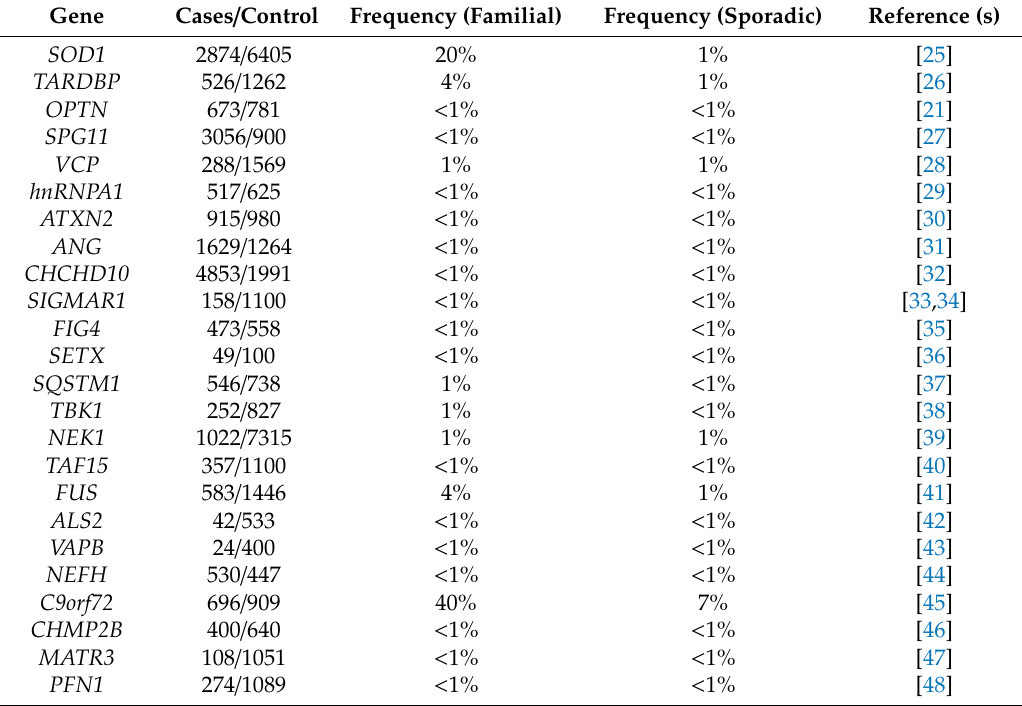
Figure 1. Proportional contribution of mutated genes in ALS and timeline of ALS gene study. ( A ) The proportion of mutant genes in fALS cases. ( B ) The proportion of mutant genes in sALS cases. ( C ) Timeline of ALS gene discoveries and researches for SOD1 , TARDBP , FUS , and C9orf72 . The Y -axis shows the number of publications in PubMed that include the terms “ALS” and “the gene name” by year until November 2020. Table 1. Genes known to carry ALS-causing mutations.